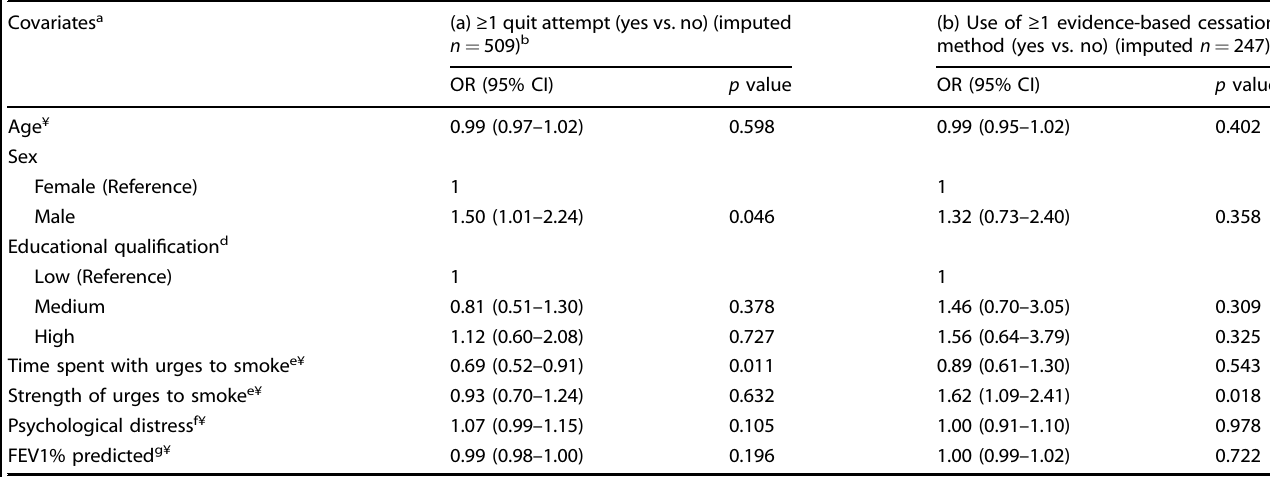
Data were presented as odds ratios (OR) and 95% con fi dence interval (CI). a Analyses were adjusted for all listed